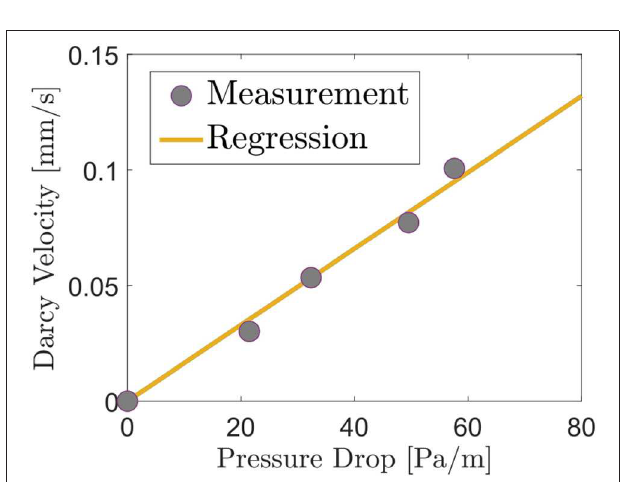
FIGURE 3 | Darcy velocity q vs. pressure drop 1 p for the Newtonian fluid (66.7 vol% Glycerol + 33.3 vol% D.I. water) used in the permeability K µ Newt estimation, κ 4.4 10 − 8 m 2 . = = ·